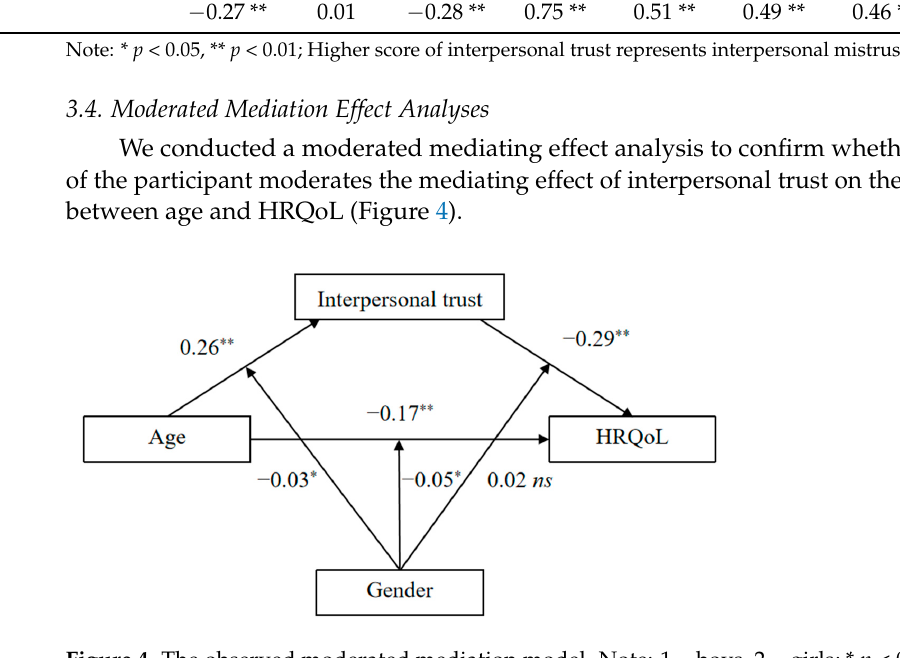
Figure 4. The observed moderated mediation model. Note: 1 = boys, 2 = girls; * p < 0.05, ** p < 0.01; Higher score of interpersonal trust represents interpersonal mistrust. Table 4. Moderated mediating effect analyses.